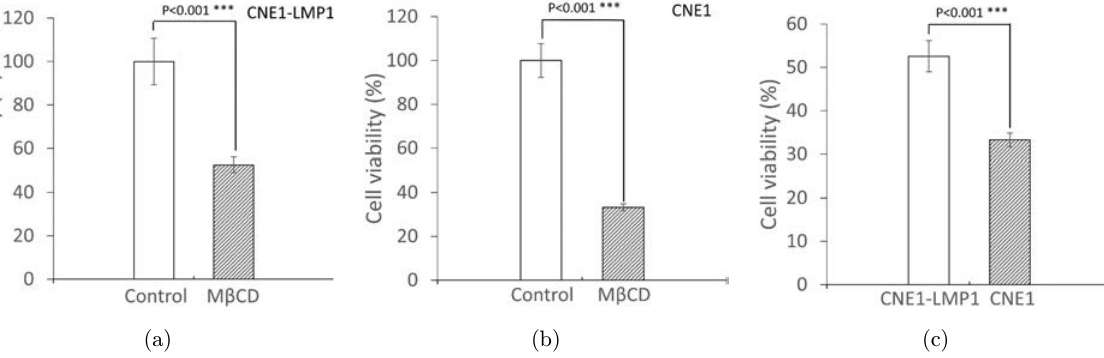
Fig. 1. Cytotoxicity of M (cid:1) CD in CNE1-LMP1 cells and CNE1 cells. (a) Viability of CNE1-LMP1 cells, (b) viability of CNE1 cells, and (c) di®erences of viability between CNE1-LMP1 cells and CNE1 cells were measured by MTT assays after 40 mM M (cid:1) CD treatment for 30 min at 37 (cid:1) C. Data represents the mean (cid:4) SD of at least three experiments. Di®erences between two groups were compared by Student's t